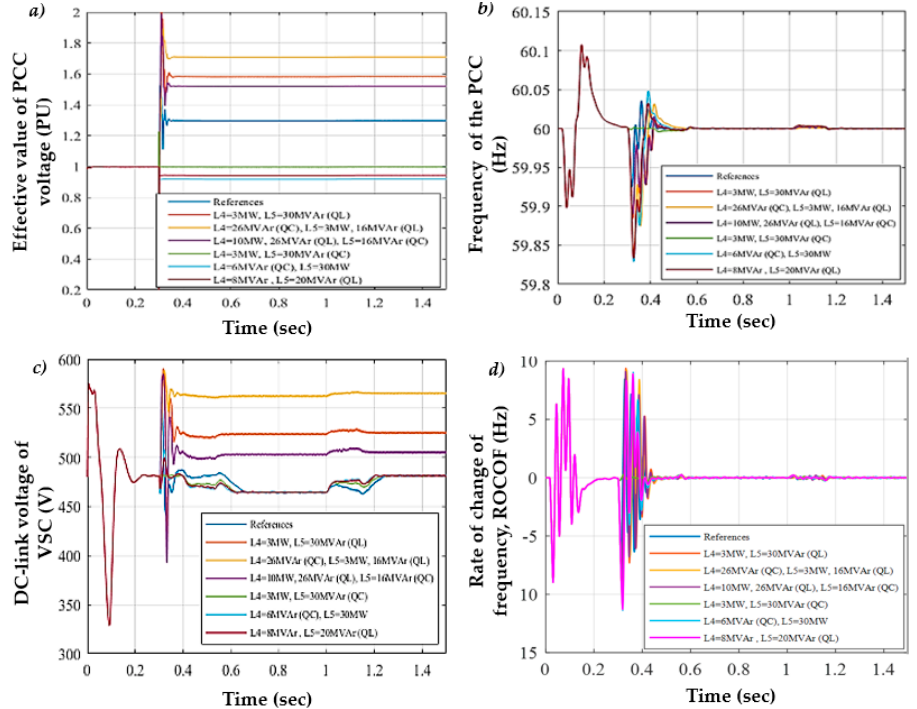
Figure 13. Simulation case of changing the loads, ( a ) the effective voltage value; ( b ) variation of the frequency; ( c ) the dc-link voltage of voltage source control; ( d ) rate of change of frequency in load switching for non-islanding.